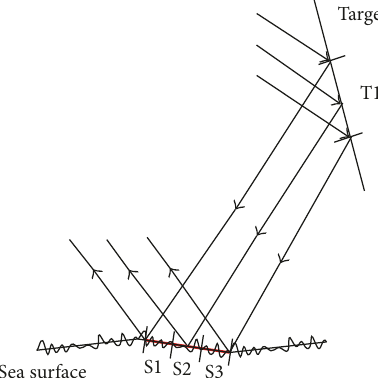
Figure 2: Illustration of ray tracing for coupling interaction of ship-